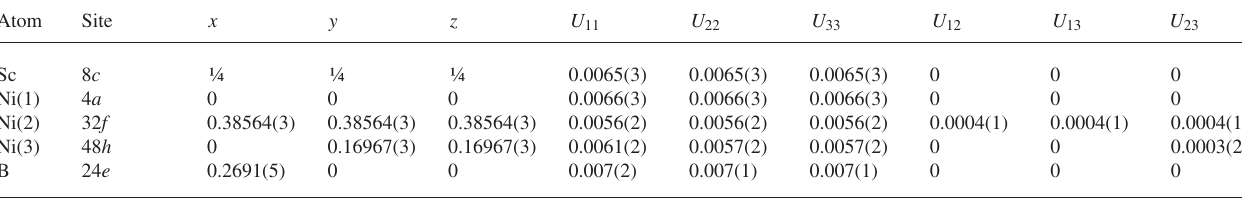
Table 2. Atomic coordinates and displacement parameters (in Å 2 ).